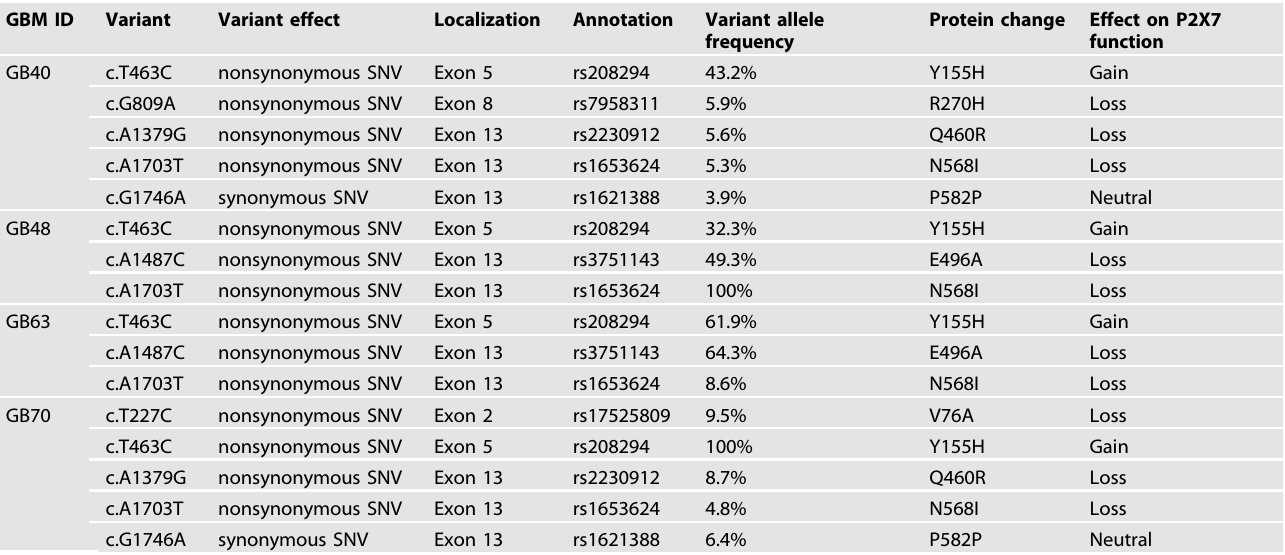
Table 1. Exonic variants of P2RX7 gene in GBM